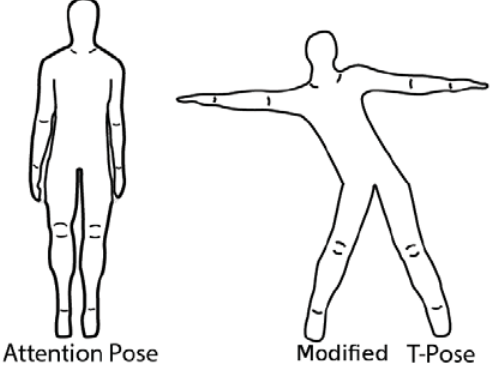
Figure 5. Two poses for performing the calibration routine.